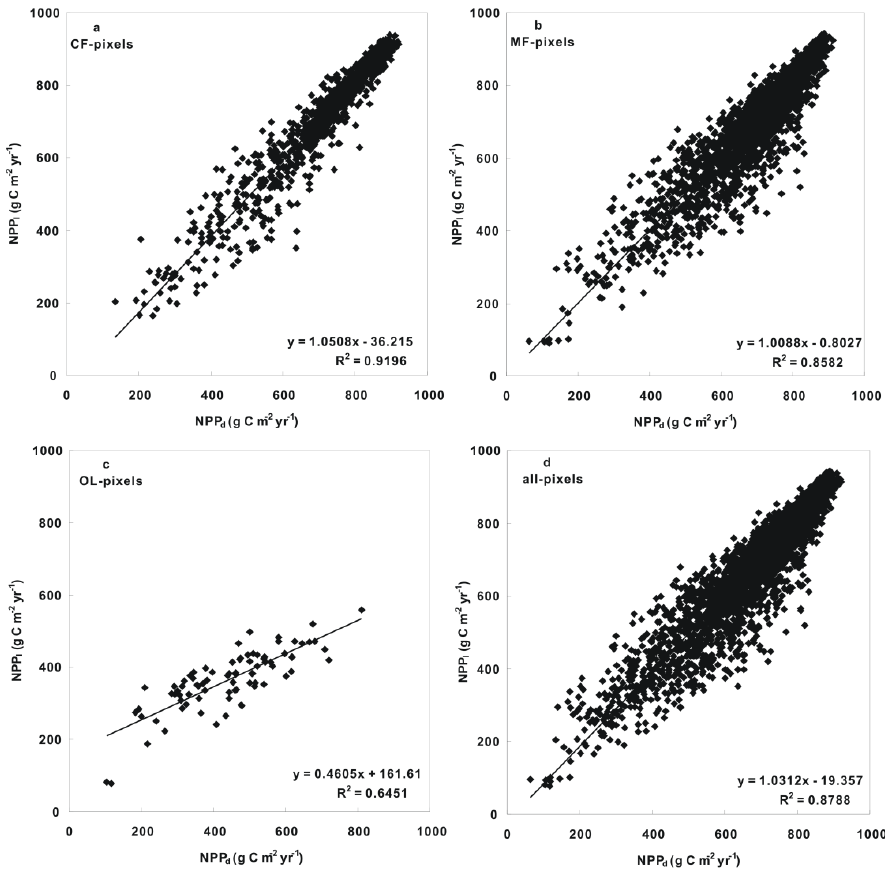
Figure 10. Regression between distributed ( NPP d ) and lumped ( NPP l ) annual values after land cover and LAI (SSI LC + LAI ) correction: (a) pix- els dominated by the coniferous forest (CF-pixels); (b) pixels dominated by the mixed forest (MF-pixels); (c) pixels dominated by open land (OL-pixels); and (d) all pixels for all land cover types (all-pixels).